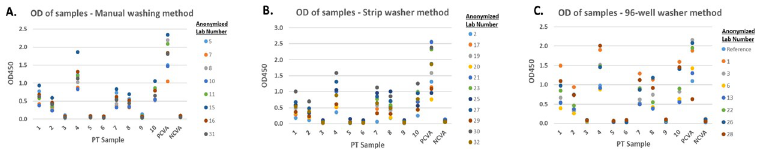
Fig 3. Individual Laboratory OD Values According to Three Different YF MAC-HD Washing Methods during the 2019 Yellow Fever Proficiency Testing Exercise. A. Comparison of individual PT sample YF antigen OD values across eight anonymized laboratories that performed manual hand washing using a multichannel pipette during the 2019 YF PT Exercise. B. Comparison of individual PT sample YF antigen OD values across 11 anonymized laboratories that performed automatic strip-well washing during the 2019 YF PT Exercise. C. Comparison of individual PT sample YF antigen OD values across seven anonymized laboratories that performed automatic 96-well head manifold washing during the 2019 YF PT Exercise. Abbreviations: YF–yellow fever; PT–proficiency testing; OD– optical density; PCVA–positive control reacted on YF viral antigen; NCVA–negative control reacted on YF viral